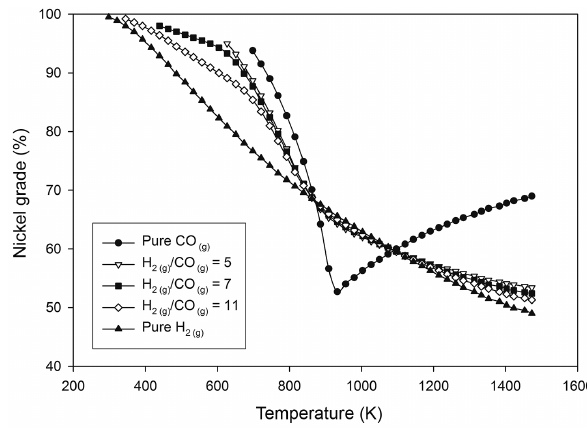
Figure 15: Effect of temperature on the nickel grade of the ferronickel for reduction of the calcined ore in pure carbon monoxide, pure hydrogen and various hydrogen to carbon monoxide ratios at a reductant to ore ratio of 0.558 kmol/100 kg.